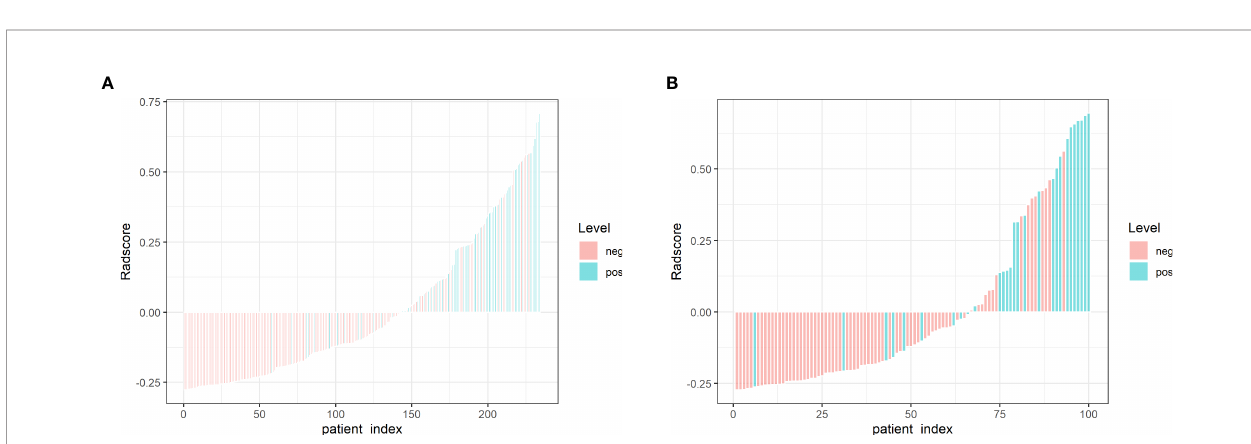
FIGURE 4 | Bar charts of Radscore for each patient in the training cohort (A) and testing cohort (B) . The X-axis represents each patient, each bar represents one patient. Pink bars indicate the Radscore for patients without LVI, while light blue bars indicate the Radscore for patients with LVI. Pink bars above zero-line or light blue bars below the zero-line mean misclassi fi